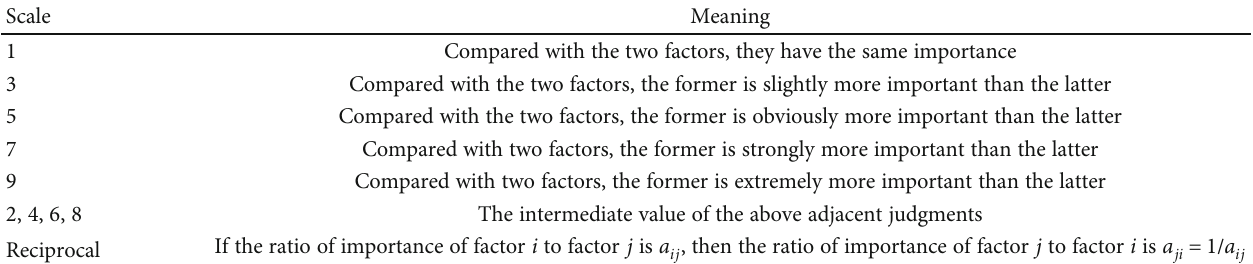
Figure 1: Hierarchical analysis structure model for water richness evaluation of the K Table 1: Scale and meaning of judgment matrix.